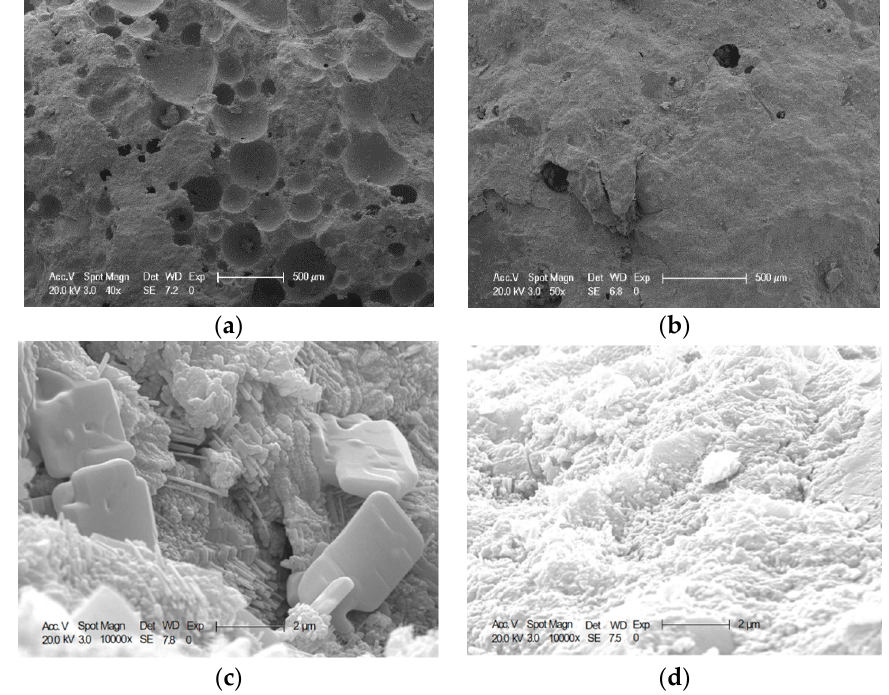
Figure 9. ( a , c ) 40×, 10000× ordinary concrete (28 days curing) and ( b , d ) 50×, 10000× 10% CANCP concrete (28 days curing) SEM micrographs.